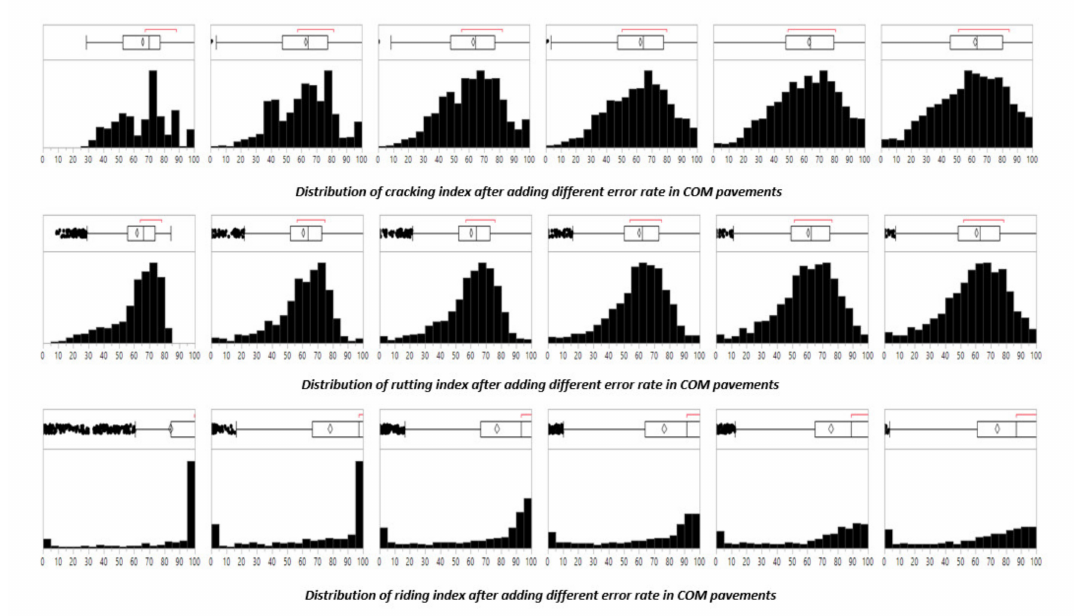
Figure 6. Distribution of individual indexes in COM pavement type after applying the different rate of errors (base scenario, 10%, 30%, 50%, 70%, and 90% rate of error, left to